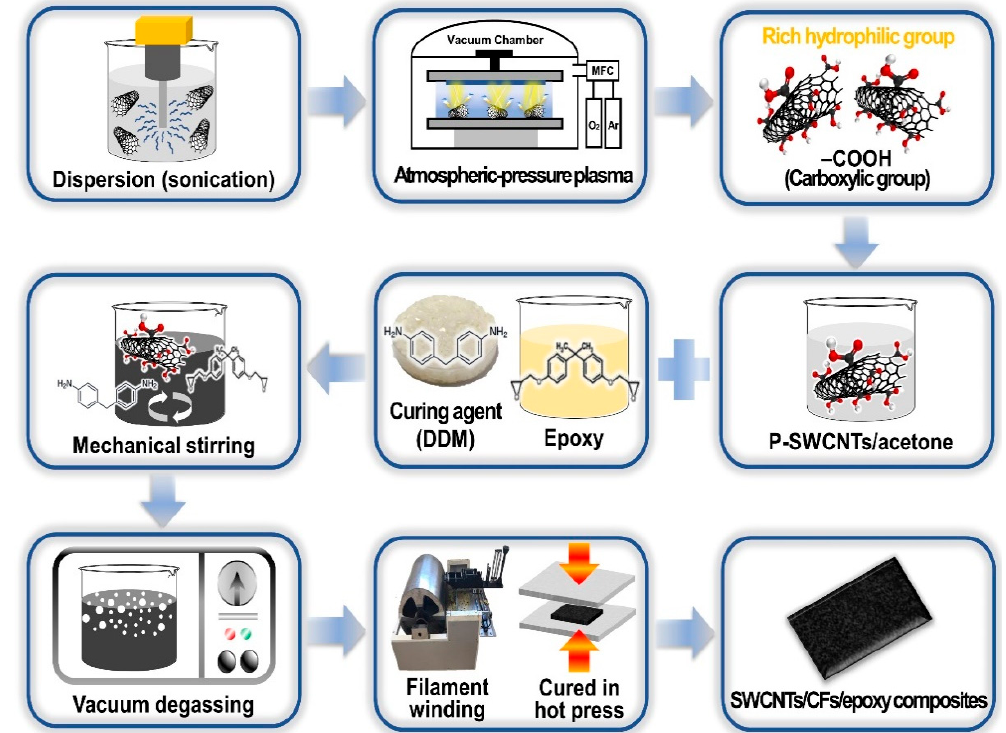
Figure 8. Preprocessing and preparing schematic diagram for P-SWCNTs/CFs/epoxy multi-scale composites.